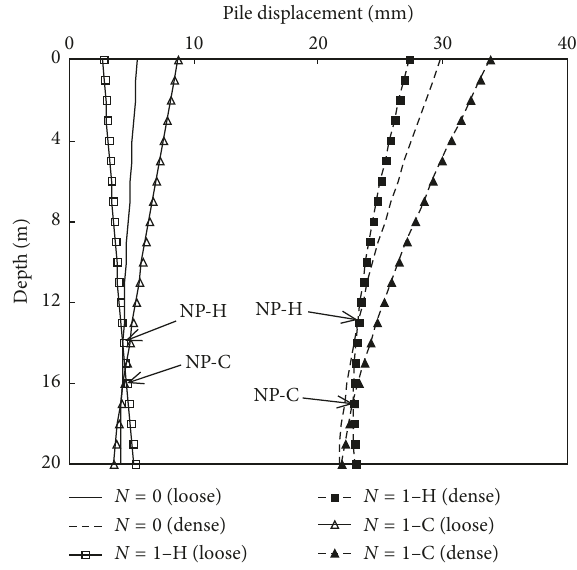
Figure 15: Location of the null point for the free head